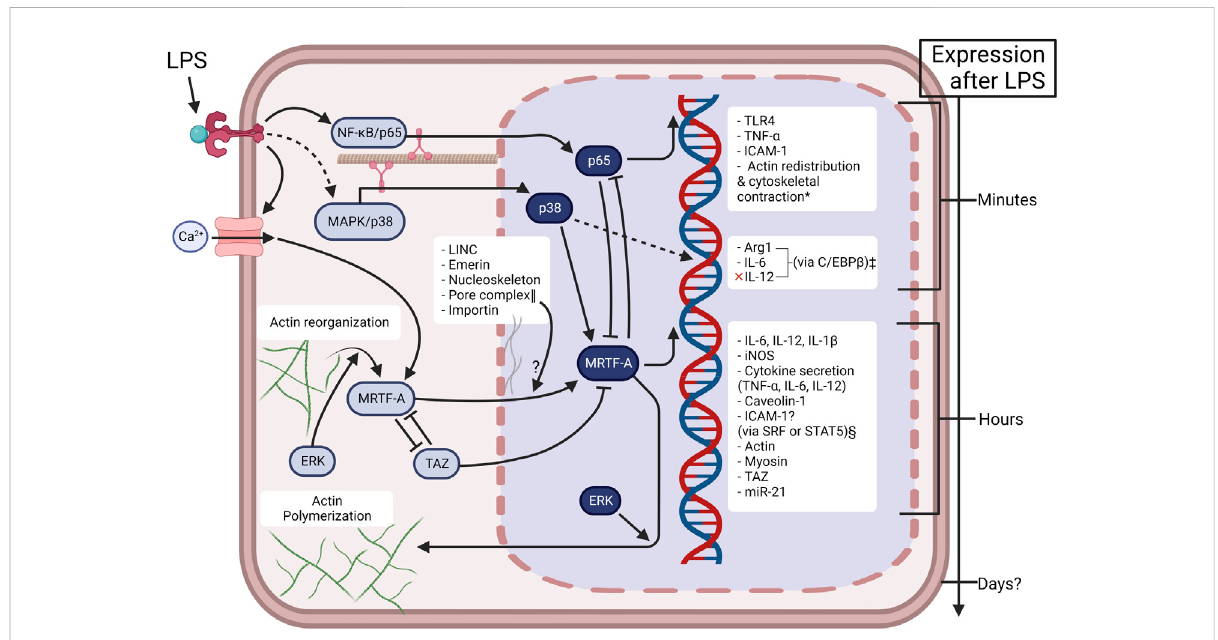
FIGURE 2 Mechanotransduction is inherently involved in M ϕ activation in a time-dependent manner. Under controlled conditions, LPS induces TLR4 “ outside-in ” signalinginthe fi rstfewhoursofactivation.SustainedLPSinduces “ inside-out ” signaling,resultinginactivationofion-channelsand actin reorganization. This causes a second mechanotransductive phase via the accumulation of MRTF-A. The present fi gure depicts the current knowledge about MRTF in M ϕ activation, but many pathways are simpli fi ed for clarity. The complicated involvement of cellular mechanical mechanisms (LINC — linker of nucleoskeleton and cytoskeleton, emerin, ERK — extracellular signal-regulated kinase, YAP/TAZ — yes-associated protein/transcriptional coactivator with PDZ domain), or physical environments (substrate stiffness, spatial con fi nement, microgravity) alters the extentofM ϕ activation.Thebidirectionalinteractionofp65andMRTFdoesnotfullyinhibitthemassomelate-transcriptionalgenesarepromotedby thep65 & MRTF complex e.g., iNOS (Miranda etal., 2021). Created with BioRender.com. *(Bian et al., 2017;Mu, 2018; Ronzier etal., 2022). ‡ (Wang C. et al., 2015). §MRTF-A epigenetic regulation of ICAM-1 is likely dependent on cell type (Sullivan et al., 2011; Yu et al., 2014; Miranda et al., 2021)and is not known in M ϕ . (cid:2) (Hoffman et al.,